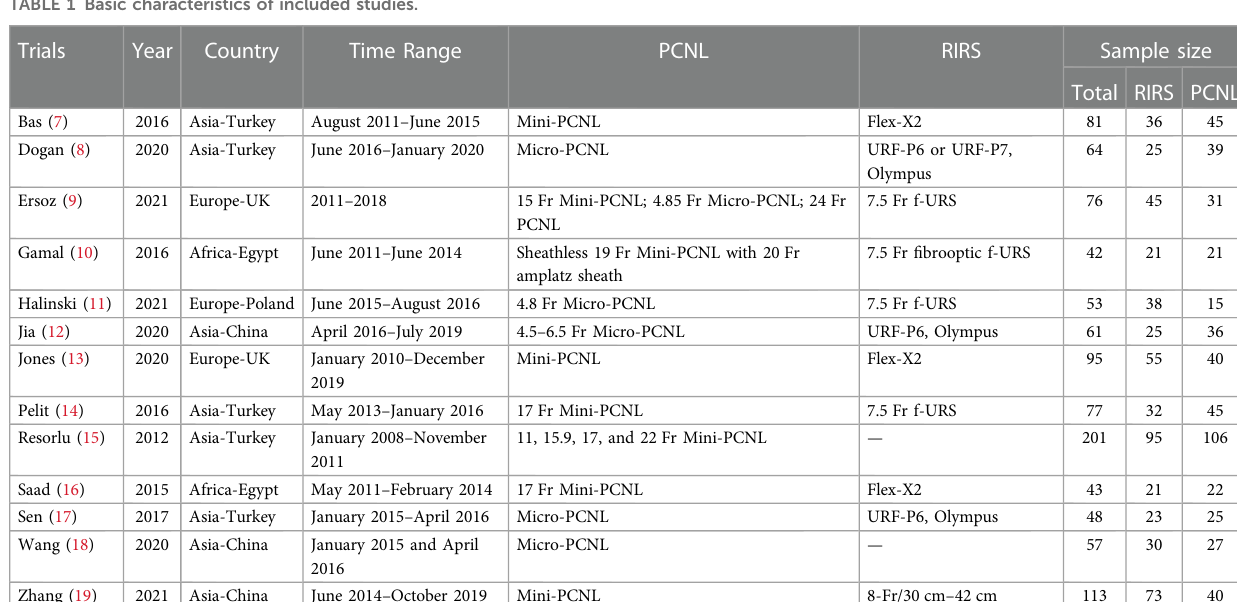
TABLE 1 Basic characteristics of included